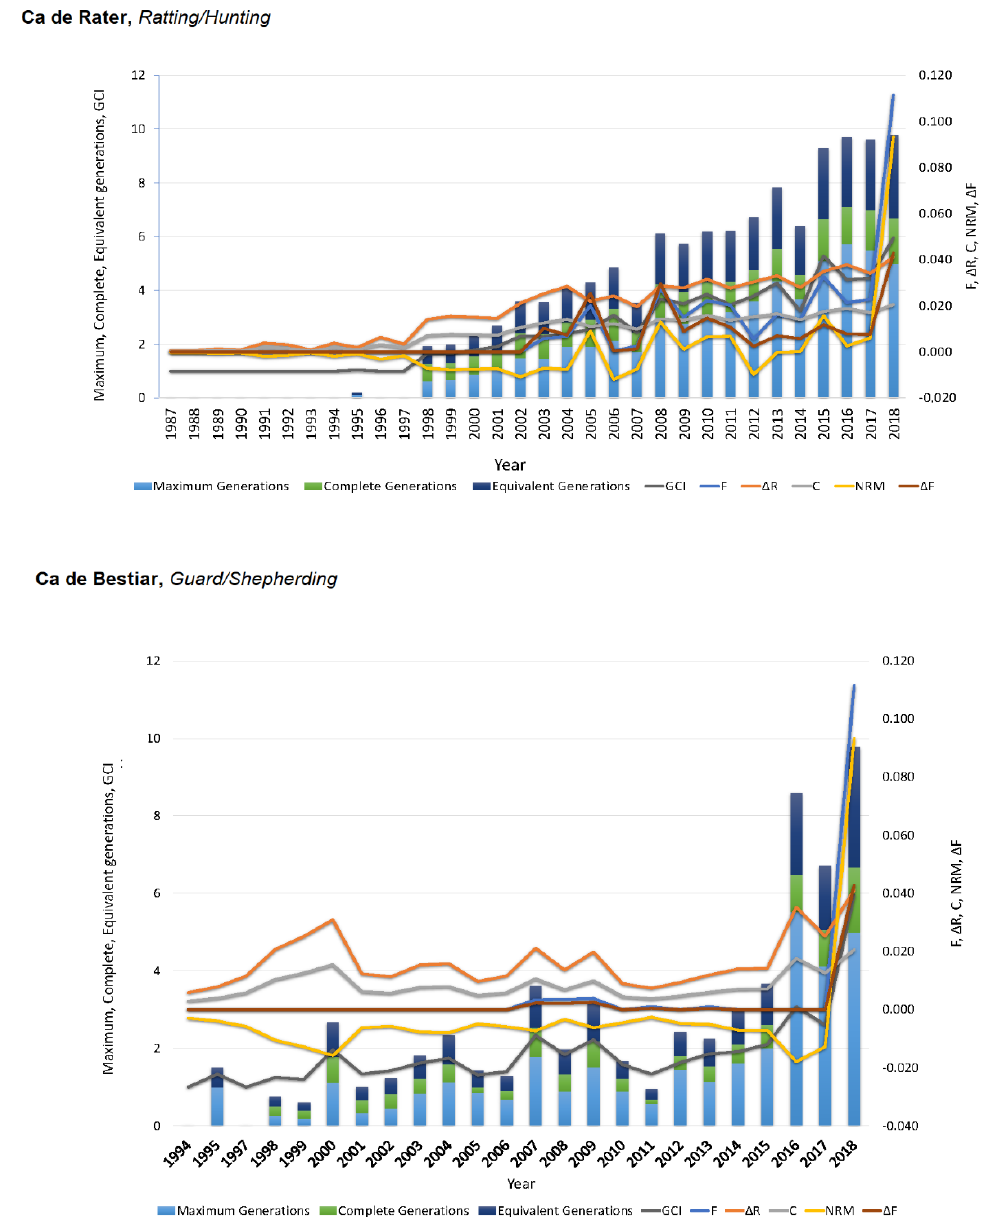
Figure 5. Trends for identity by descend estimators (F, C, ∆ F), ∆ R, nonrandom mating degree (NRM), and genetic conservation index (GCI) from 1987 to 2018 for Ca de Rater and Ca de Bestiar dog breeds. Breeder dendrograms lay the historical basis of owner dendrograms; hence, breeder pack structures can be inferred to build the skeleton of the owner pack network (Figures S1 and S2). Both breeds were predominant around the center of the island as opposed to the coastal areas, since it is in these zones where their functional aptitude, linked to production systems (cattle herding and privately owned preserves) and occupational habits of the population (vacation houses), extends.